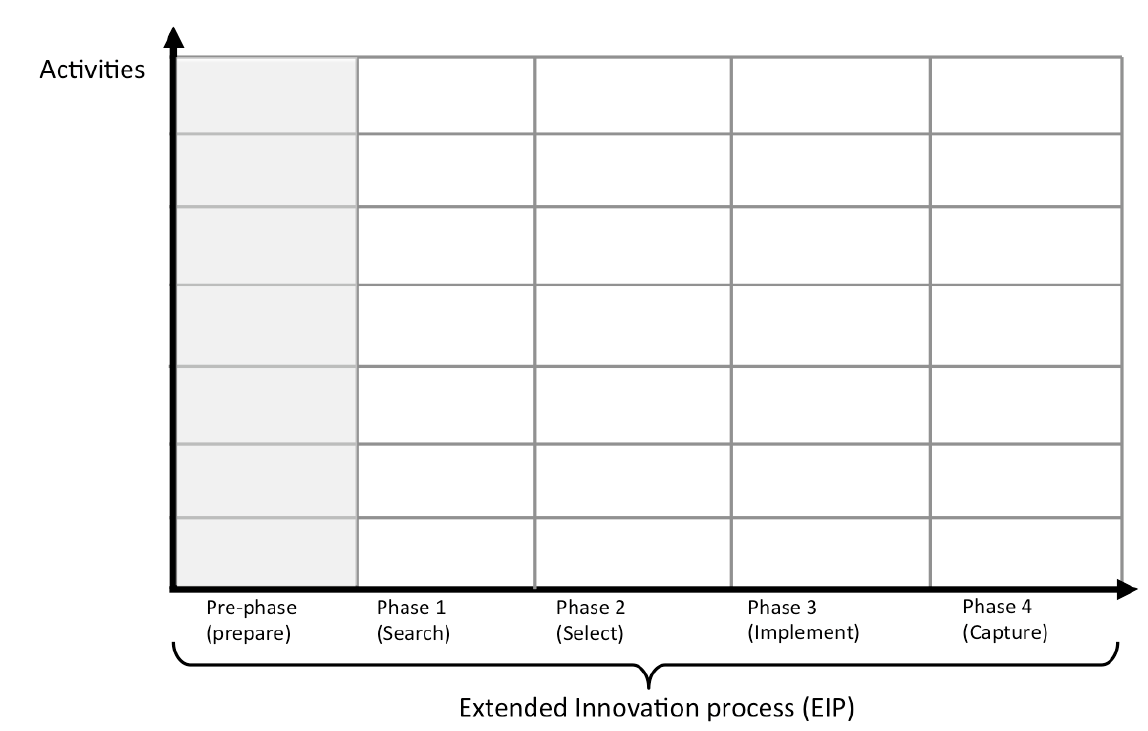
Fig. 8. The figure demonstrates the pre-phase in light grey as an extension of the innovation process illustrated as a work chart, in this case as an extension of the innovation process by Tidd and Bessant (2009) as used within this